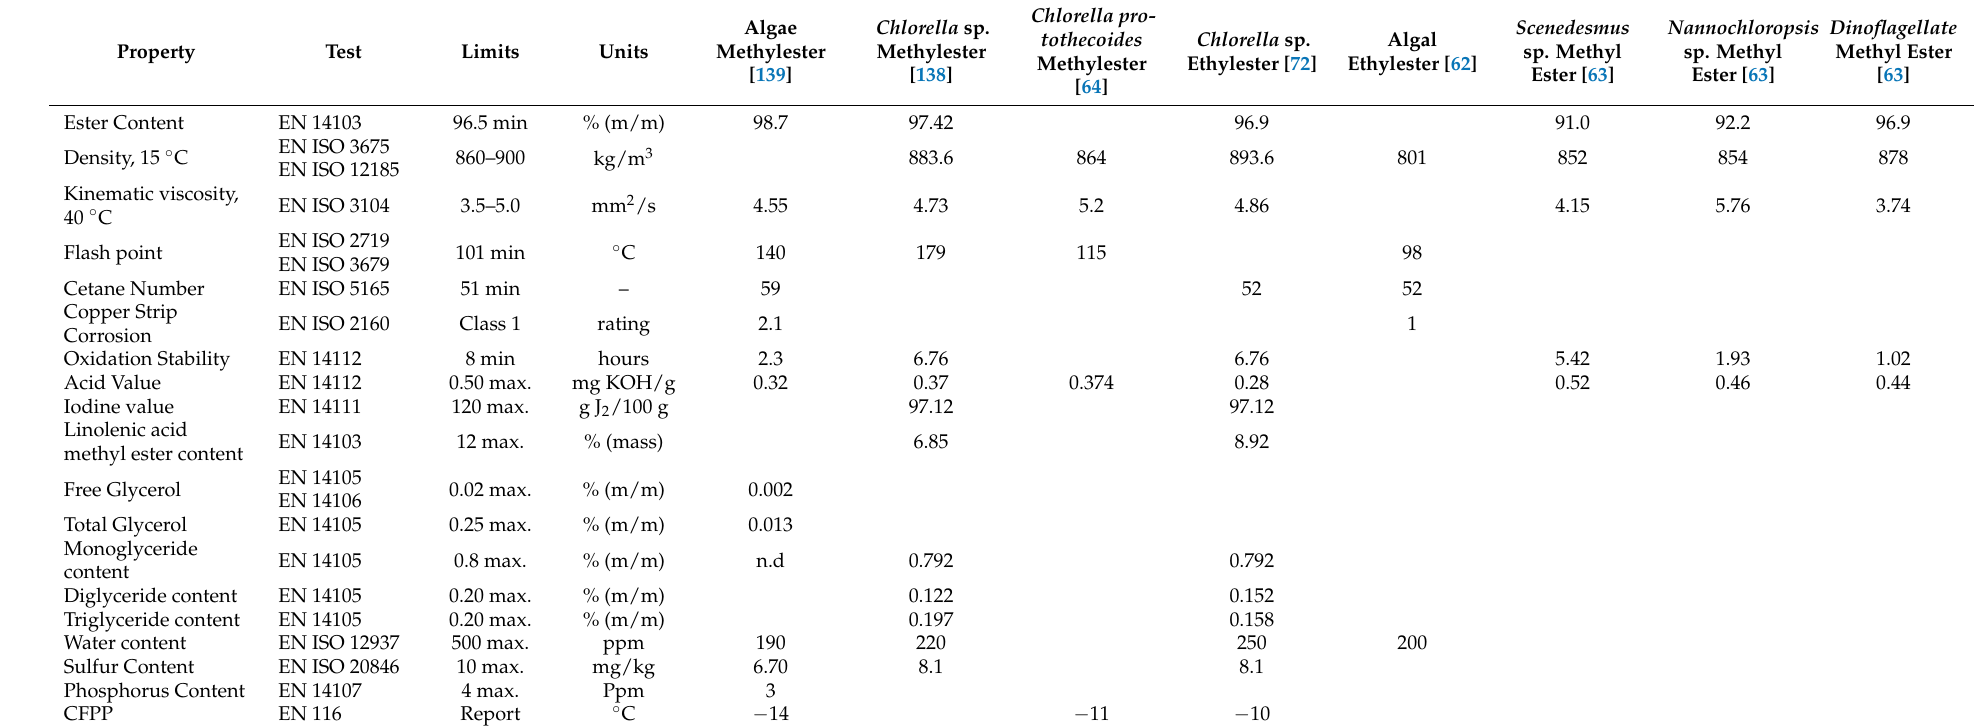
Table 11. Properties of biodiesel from different algae oils (UNE-EN